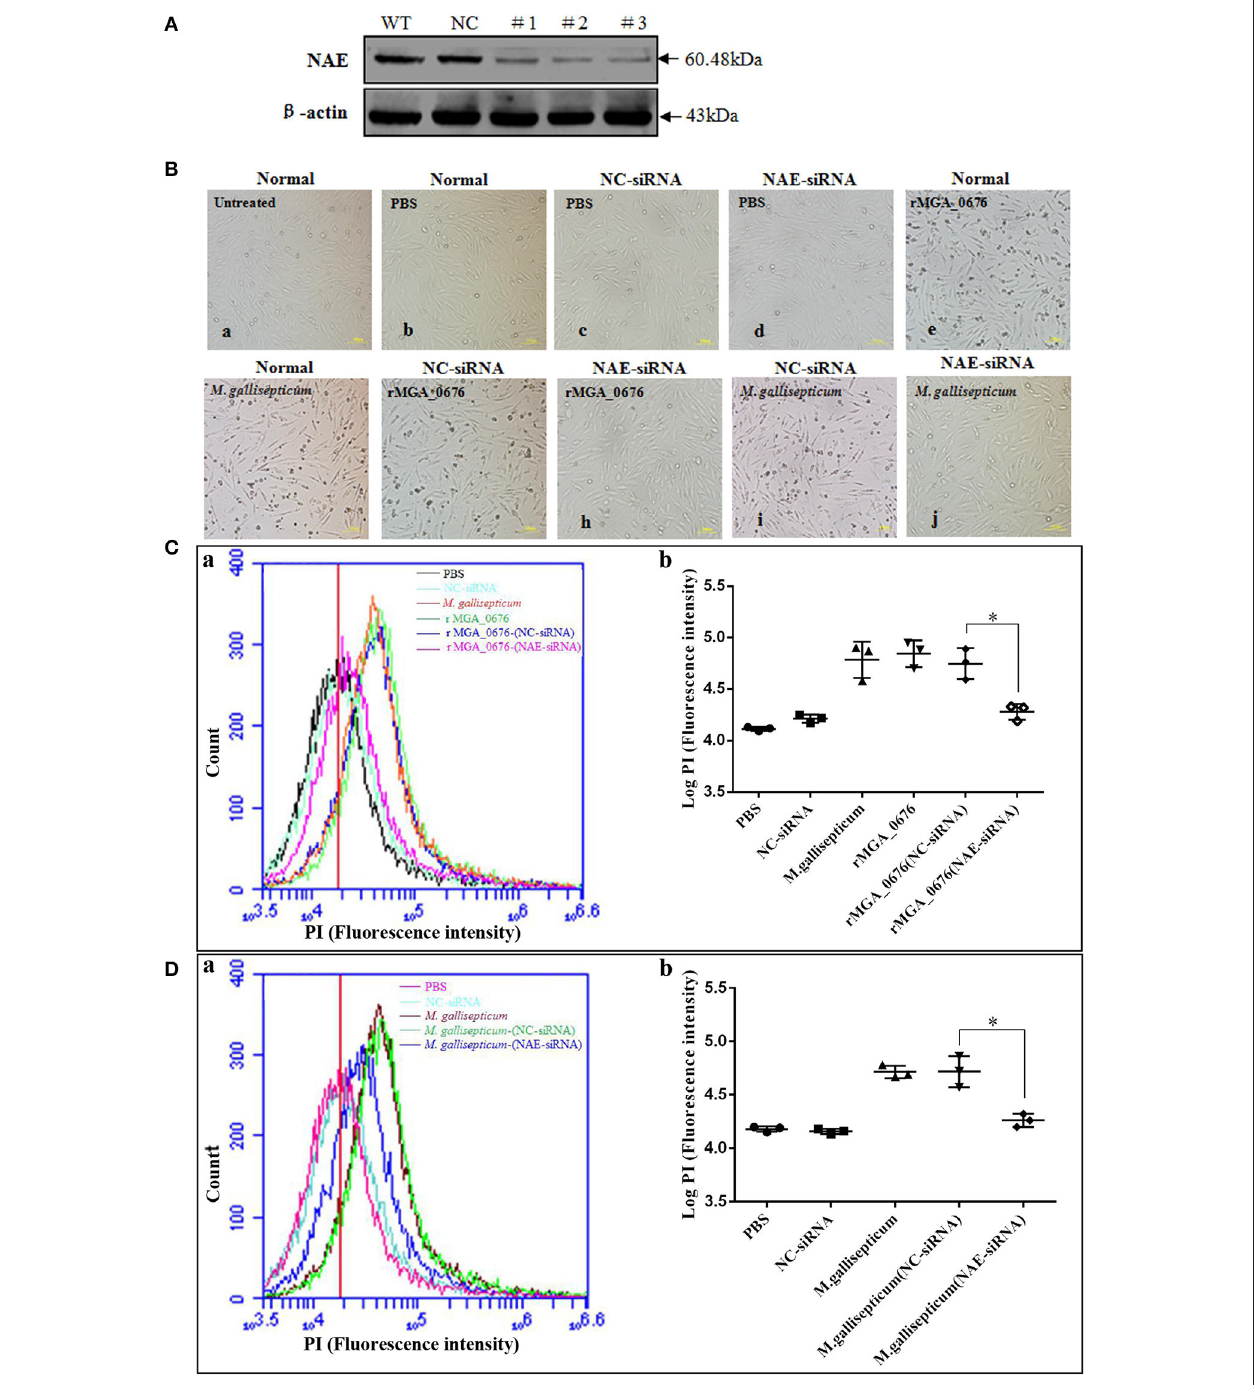
FIGURE 5 | MGA_0676 interacts with NAE inducing apoptosis in DF-1 cells. (A) Effect of NAE RNAi on the expression of endogenous NAE. DF-1 cells were transfected with siRNA (#1 to #3) or controls (WT and NC), as described in Materials and Methods. Forty-eight hours after the second transfection, cell lysates were prepared and examined by western blotting with anti-NAE antibody. Endogenous β -actin expression was used as an internal control. (B) Pathological changes in NAE inhibited DF-1 cells after rMGA_0676 treatment. All cell groups were observed with a microscope after treatment as follows. a: normal cells; b: PBS-treated; c: siRNA NC; d: siRNA NAE; e: rMGA_0676 (40 µ g/ml); f: M. gallisepticum (MOI = 10); g: siRNA NC pre-treatment, rMGA_0676 (40 µ g/ml) treatment; h: siRNA NAE pre-treatment, rMGA_0676 (40 µ g/ml) treatment; i: siRNA NC pre-treatment, M. gallisepticum (MOI = 10) treatment; j: siRNA NAE pre-treatment, M. gallisepticum (MOI = 10) treatment. Scale bar = 100 µ m. (C) Apoptosis induction by rMGA_0676 in NAE arrested DF-1 cells. The curves (a) and the scatter plot (b) represent